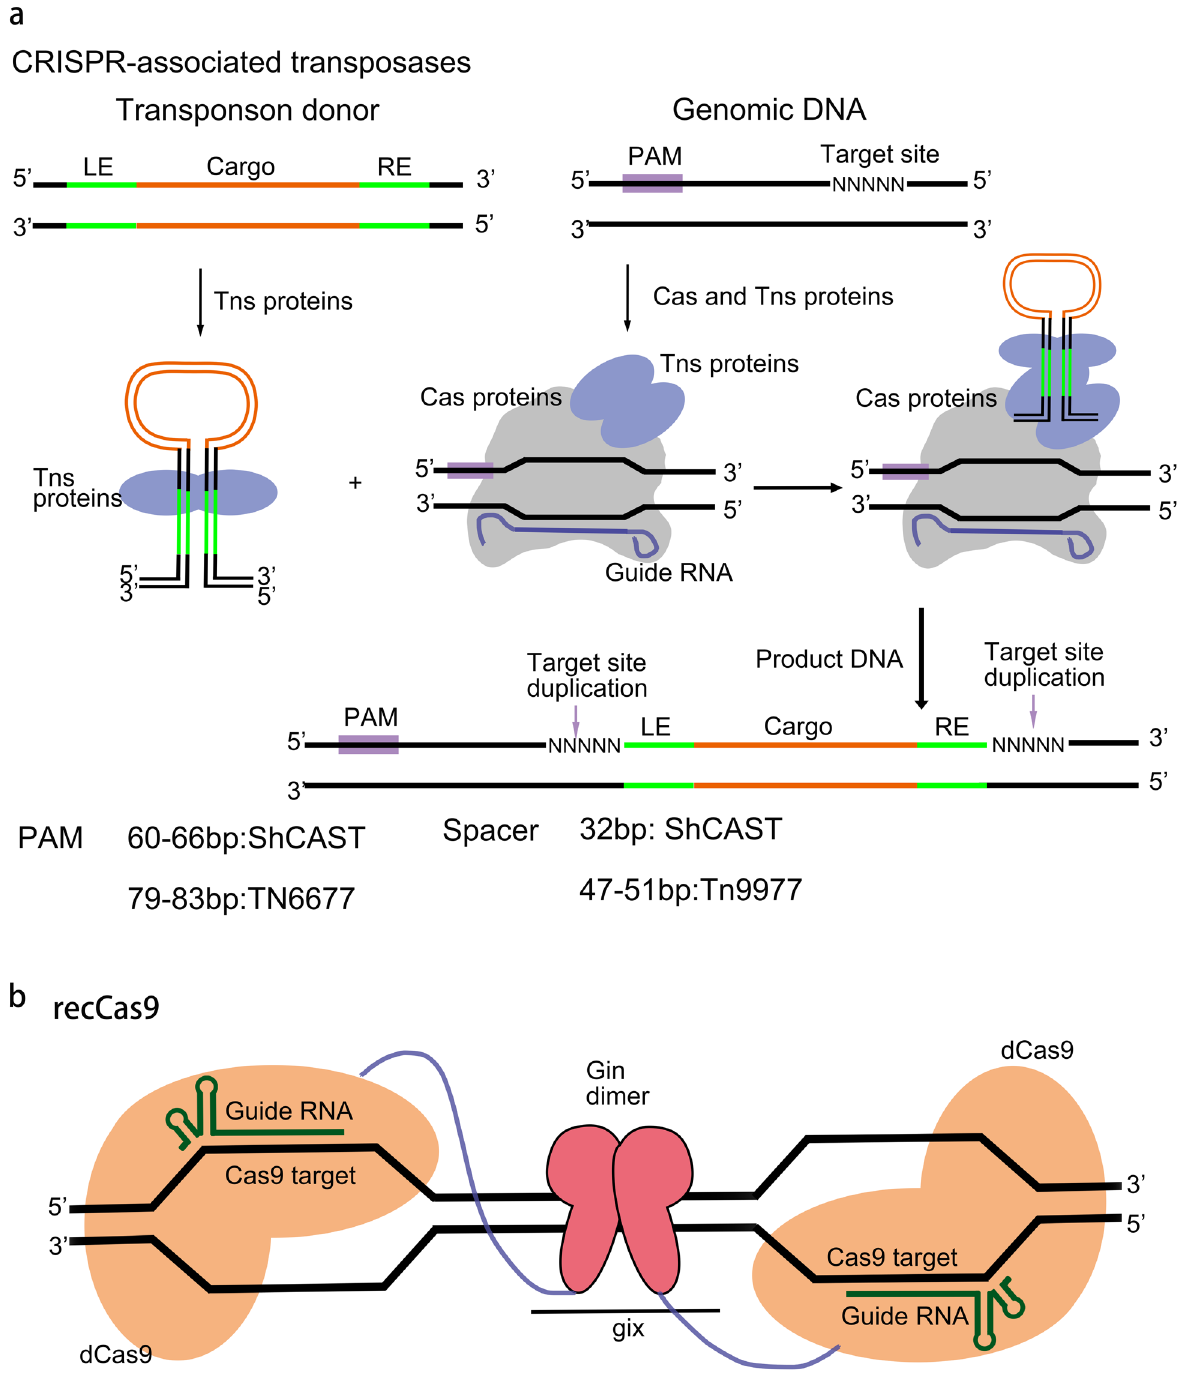
Fig. 3 CRISPR-associated transposon and recombination systems. a Cas transposases include both Cas proteins and transposase-associated components. Cargo DNA is identified by its left end (LE) and right end (RE) sequences and bound by transposase proteins (Tns). Guide RNA binding to Cas nuclease brings transposase to the specific site, and transposase integrates the DNA cargo into the target site. The target site is duplicated and flanks the integrated LE–cargo–RE sequence. Each Cas-transposase complex has a specific requirement for the spacer length of guide RNA and a unique position preference of integration site. b reassembly of guide RNA-programmed recCas9 at the target